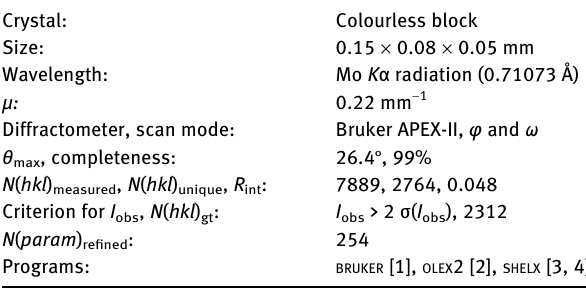
Table  : Data collection and